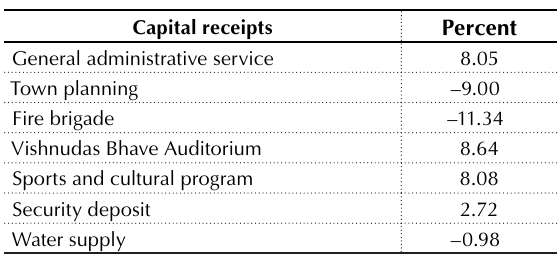
Table 4. The capital receipts of Navi